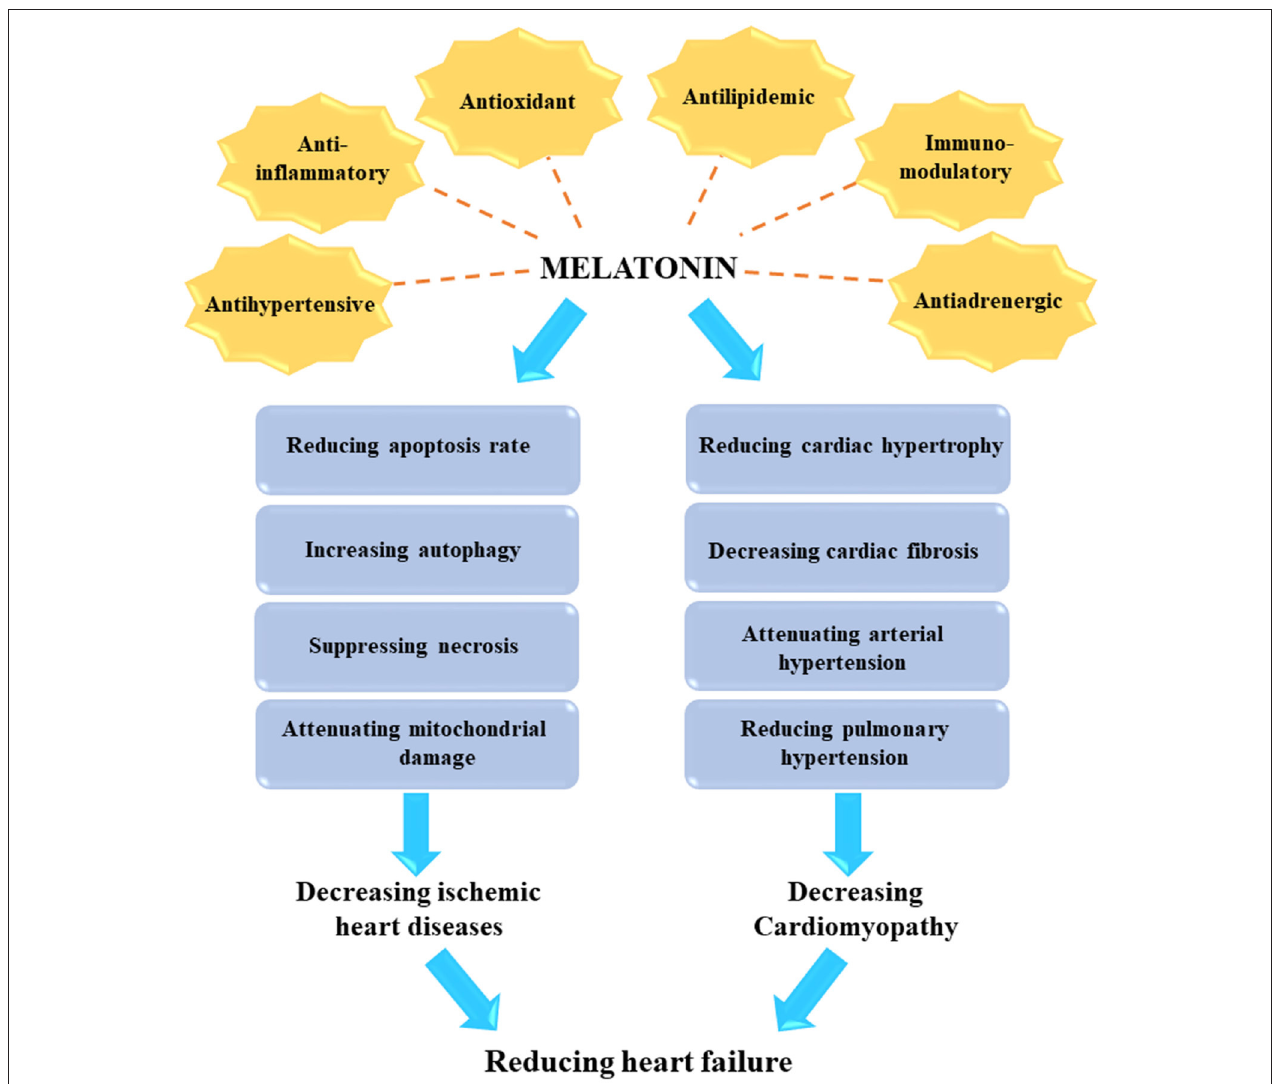
FIGURE 3 | Beneficial effects of melatonin in reducing heart